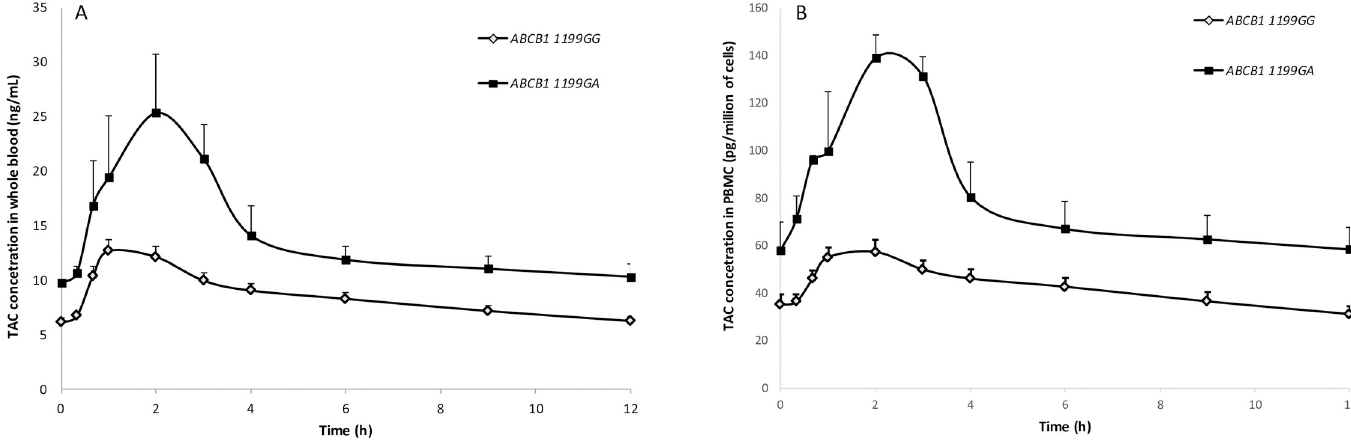
Fig 3. Influence of recipient ABCB1 1199G > A on whole blood and on intracellular (PBMC) areas under the tacrolimus (TAC) concentrations–time curve from 0 to 12 h (AUC). Each symbol represents mean ± standard deviation of the mean. (n = 29 ABCB1 1199GG, n = 3 ABCB1 1199GA).